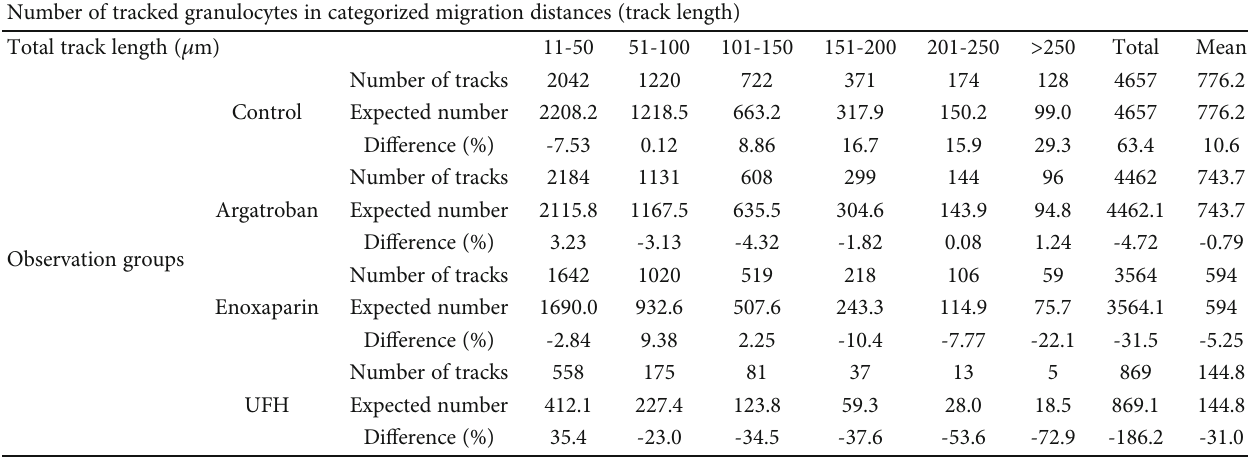
Table 2: Comparison of numbers between tracked and expected granulocytes per track length category: number of tracks of the UFH group shows the greatest deviations compared to the control group. Number of tracked granulocytes in categorized migration distances (track length) Total track length ( μ m)